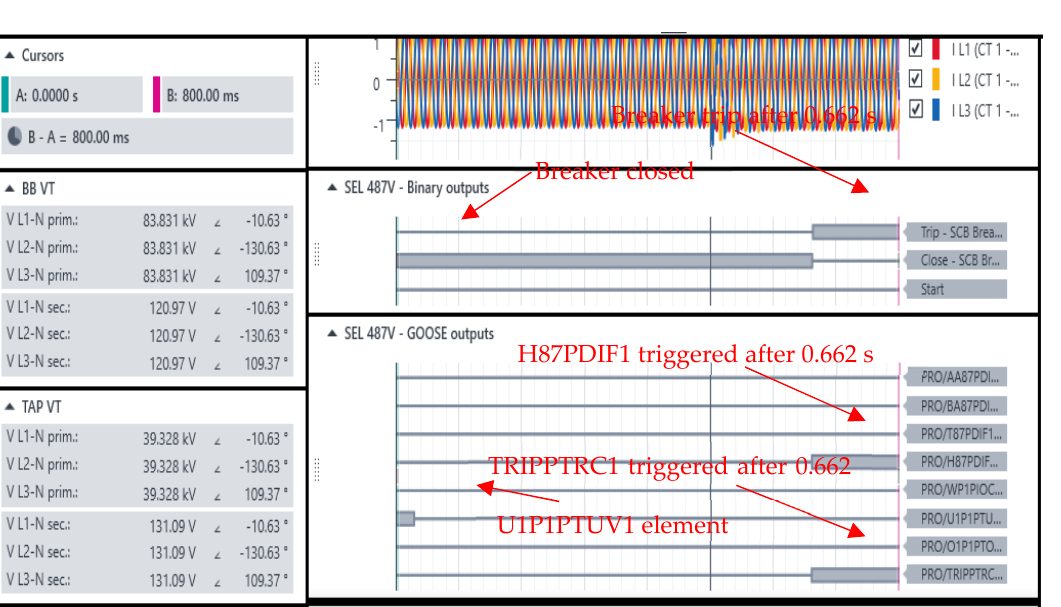
Figure 5. SynchoWAVE Event simulation results for four-element failures below the tap. Table 3. A Summary of the results for four-element failures below the tap.